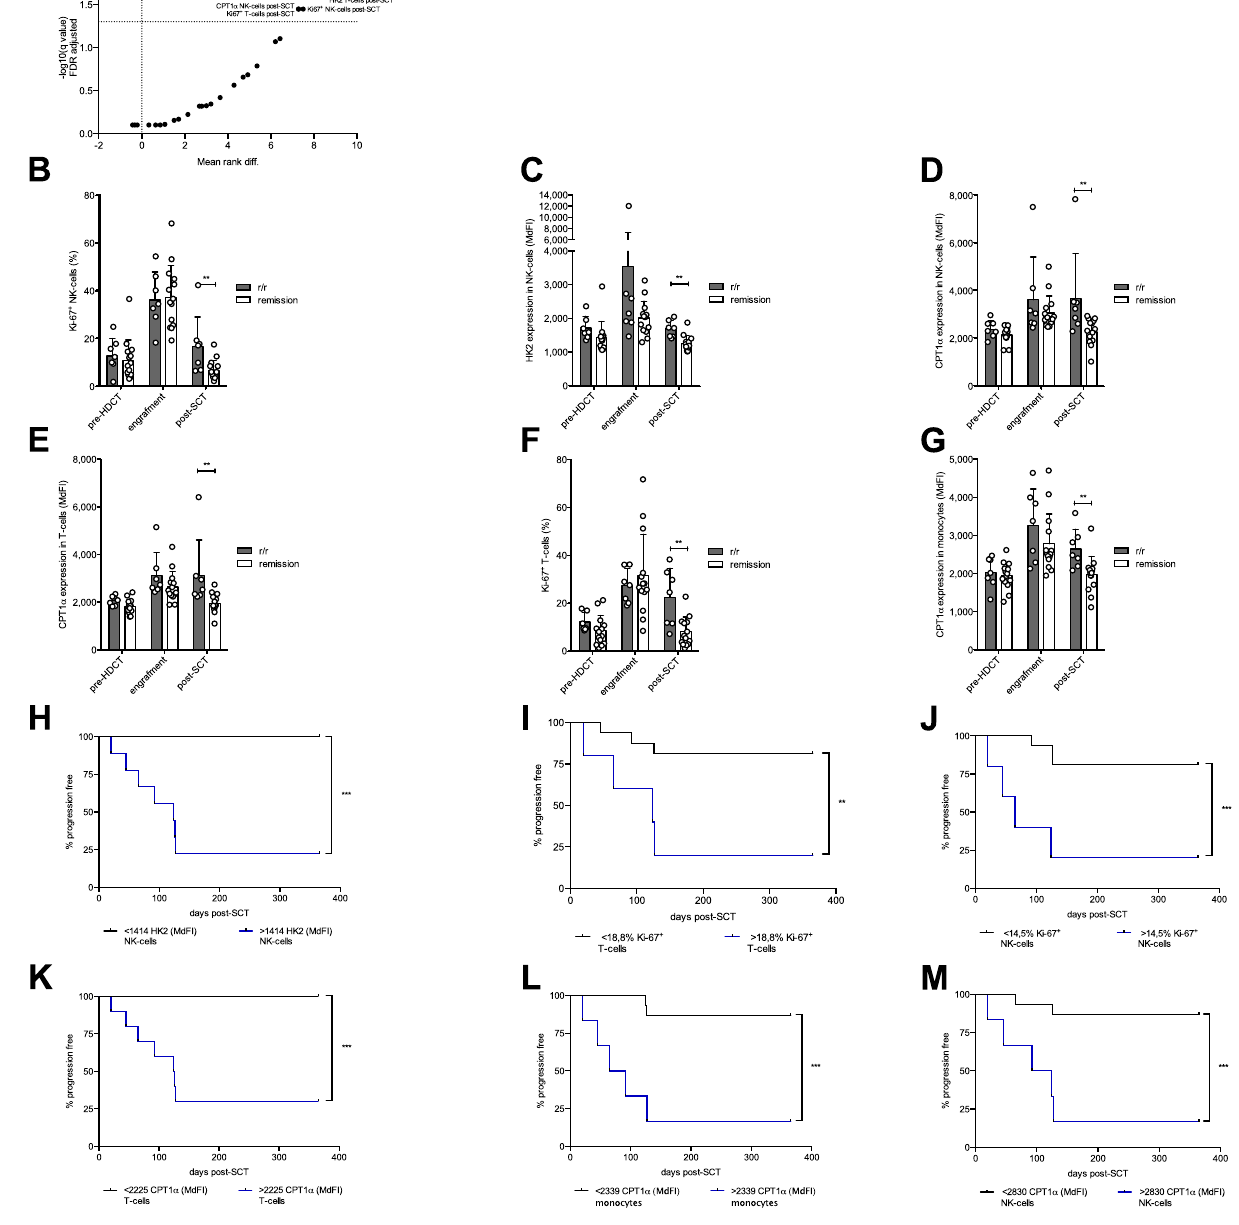
Figure 7. Persistently increased metabolic activity upon HDCT/ auto-SCT is associated with refractory or early relapse in lymphoma. ( A ) Multiple unpaired Mann–Whitney tests for Ki-67, HK2 and CPT1α expression in T-, NK-cells and monocytes at all three time points were performed to identify significant differences between lymphoma patients being refractory or relapsed (r/r) within the first year upon SCT and lymphoma patients being still in remission (remission) at this time point. P-values were adjusted using False-Discovery-Rate adjustment. ( B ) Ki-67, ( C ) HK2 and ( D ) CPT1α expression in NK-cells as well as ( E ) CPT1α and ( F ) Ki-67 in T-cells and ( G ) CPT1α expression in monocytes were plotted. All results of the CPT1α and HK2 expression are plotted as median fluorescence intensity (MdFI) whereas Ki-67 is plotted as percentages of all Ki-67 + cells (n: 7 refractory/ relapsing and 14 non-relapsing lymphoma patients, mean values +/− SD). ( H-M ) Area under the Receiver operating characteristic (ROC) curve analysis was used to define an optimal cutoff value for each parameter for further evaluation and grouping for survival analysis (Supplementary Figure S3–8). Cut off values were selected according to highest sensitivity (true positive rate) and specificity (true negative rate) and high Likelihood ratio (LR). Tumor progress within one year was recorded as an event. For comparison of progression free survival curves a Log-rank (Mantel Cox) test was performed. *P < .05; **P < .01; ***P <